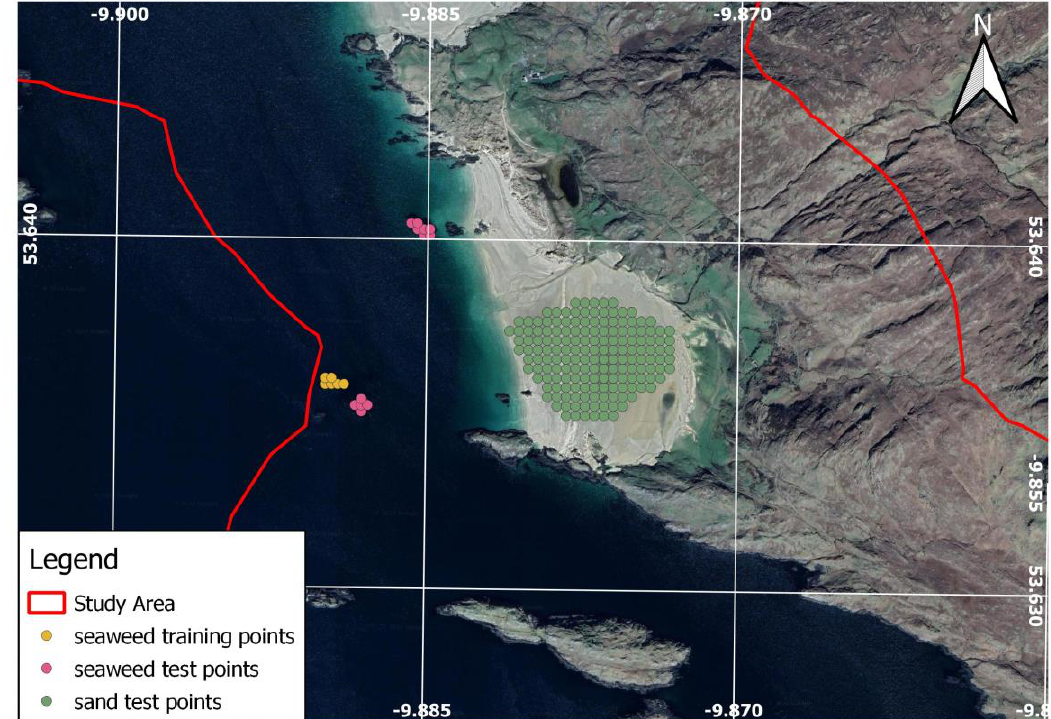
Figure 3 . Example of different classes training and validation